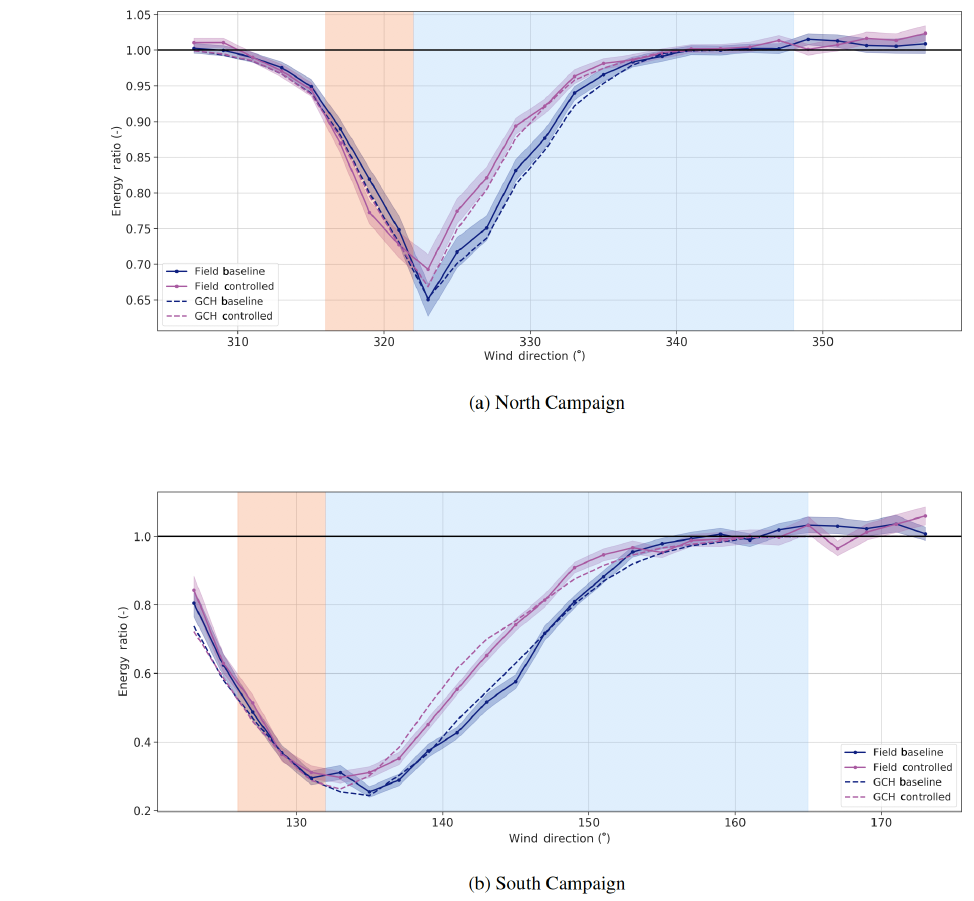
Figure 7. Energy ratio of T3 for the North and South Campaigns. For both campaigns, this represents the ratio of energy produced by T3 with respect to unwaked reference turbines. The banded region, as explained in Fig. 5, indicates regions of offset activity, either intended (light blue) or unintended (orange).